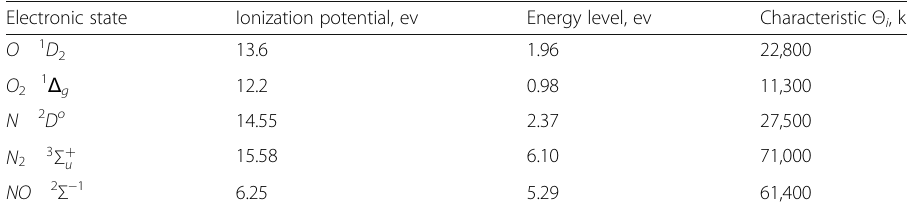
Table 1 First excited quantum state and characteristic ion temperatures